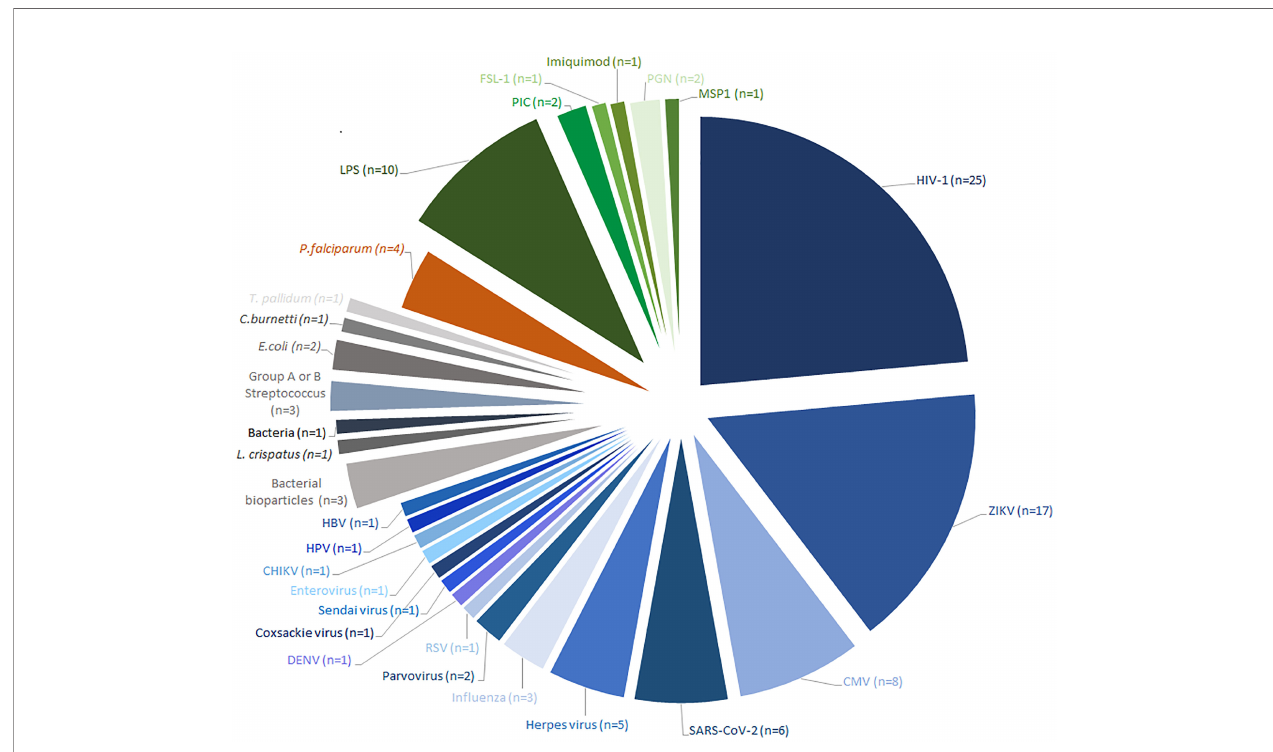
FIGURE 2 | Overview of all studies that have investigated pathogen infection or pathogen responses in Hofbauer cells. All identi fi ed studies published before 20 th May 2021 were categorized by pathogen, or Pathogen-Associated Molecular Pattern (PAMP) studied. Viral infections are represented in blue, bacterial infections in grey, parasitic infections in orange and PAMP treatments in green. The number of articles that investigated each pathogen or PAMP is indicated in parentheses. HIV Human Immunode fi ciency Virus, ZIKV Zika virus, CMV Cytomegalovirus, RSV Respiratory syncytial virus, DENV Dengue virus, CHIKV Chikungunya virus, HPV Human papillomavirus, HBV Hepatitis B virus, L. crispatus Lactobacillus crispatus, E.coli Escherichia coli, T.pallidum Treponema pallidum, C.burnetti Coxiella burnetii, P.falciparum Plasmodium falciparum, LPS lipopolysaccharide, PIC Polyinosinic:polycytidylic acid, FSL-1 Pam2CGDPKHPKSF-synthetic lipopeptide, PGN Peptidoglycan, MSP1 Merozoite surface